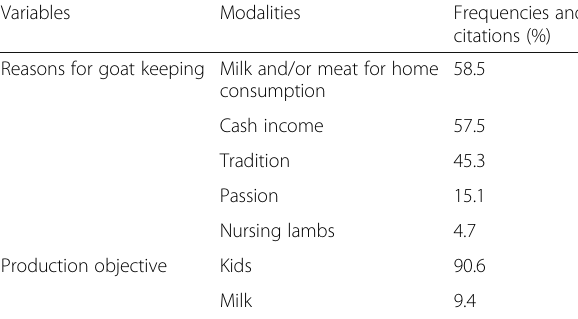
Table 3 Purpose and production objective of goat